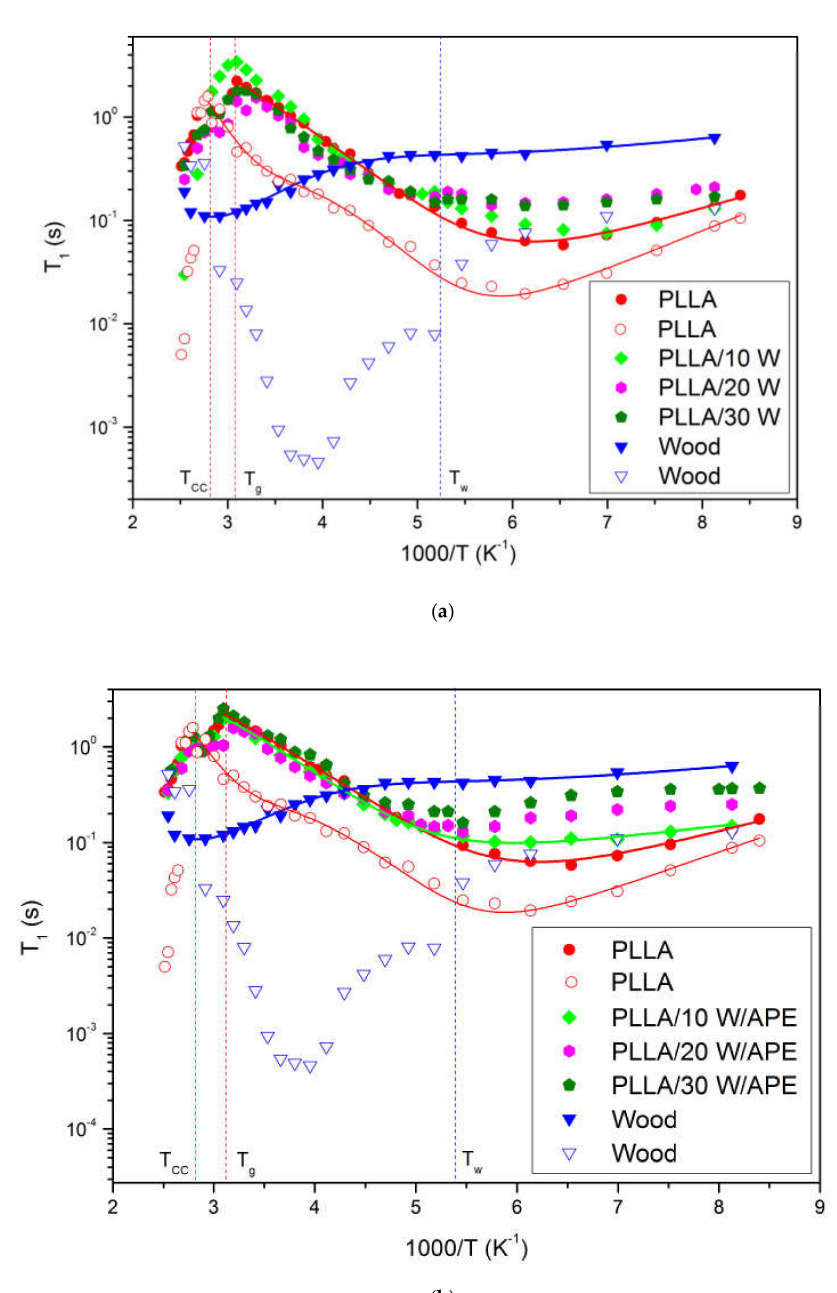
Figure 4. The temperature dependence of spin-relaxation time T 1 for ( a ) PLLA / W and ( b ) PLLA / W / APE samples. The solid lines are example fits of Equation (2) with experimental data. Dashed lines emphasize phase transitions occurring in the systems (cold crystallization temperature T cc , glass temperature T g , and the phase transition occurring in wood T w ). Long T 1L and short T 1S components of relaxation times are marked with full and empty symbols,